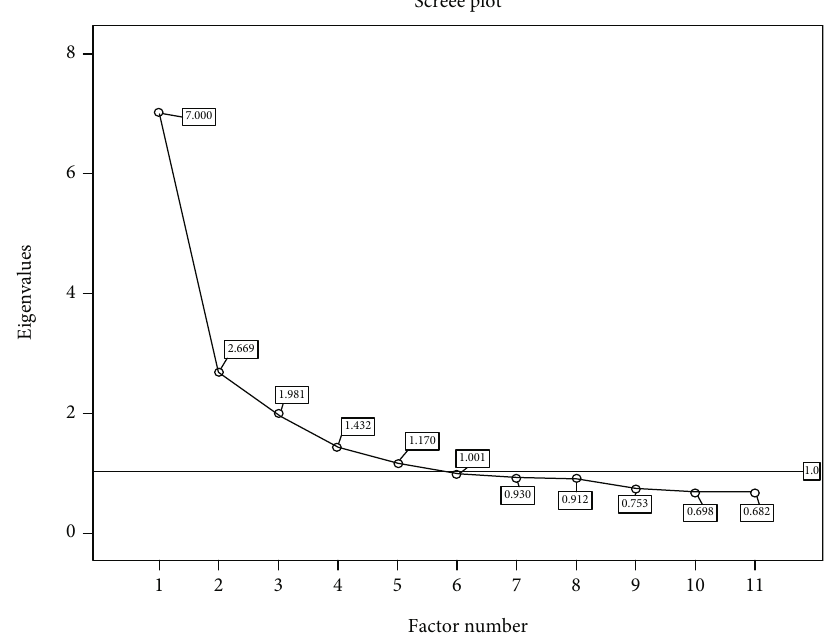
Figure 2: The horizontal axis represents the number of factors, and the vertical axis represents the characteristic value. As shown in the fi gure, the eigenvalues of Factors 1 to 6 were all greater than 1.